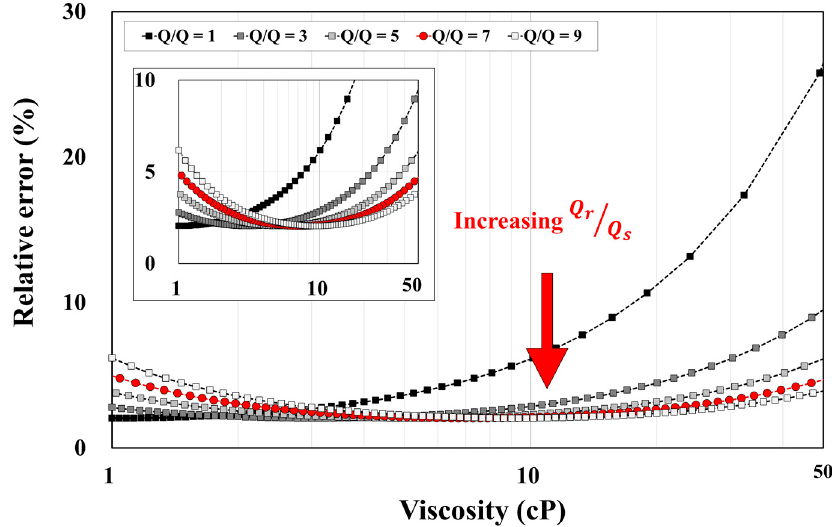
Figure 2. Optimal flow rate ratio of the reference and sample fluids. The x-axis represents the viscosity to be measured in the counting section; the y-axis represents the expected relative error that is calculated for the case when a single channel for PBS is mistakenly counted. Flow rate ratio ( Q / Q ) means the ratio of the reference ( Q r ) and sample fluid ( Q s ). As the input flow rate of the reference fluid increases relative to the flow rate of the sample fluid, the relative error decreases in the viscosity range above 10 cP. However, as depicted in the inset, the increasing flow rate ratio also induces an elevated relative error in the low viscosity range near 1 cP. Consequently, the optimal condition of the flow rate ratio, which ensures a relative error of less than 5% over the whole range of viscosities, is set to seven (red circle).